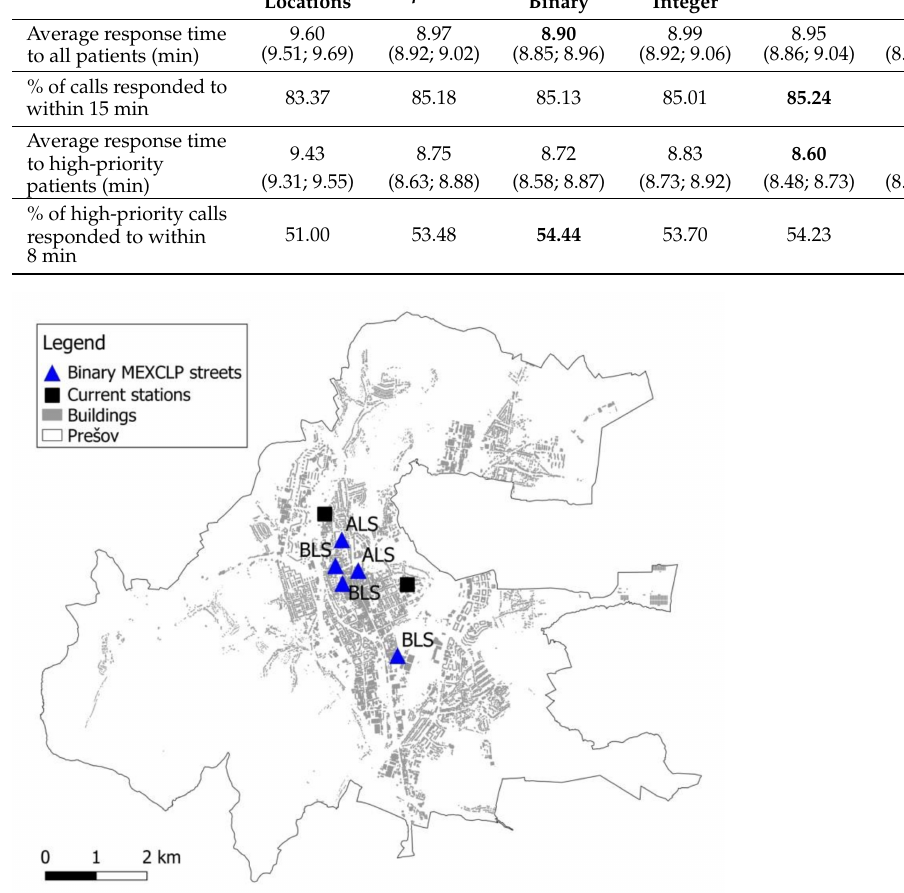
Figure 7. Ambulance locations using the binary MEXCLP model with the street demand model.